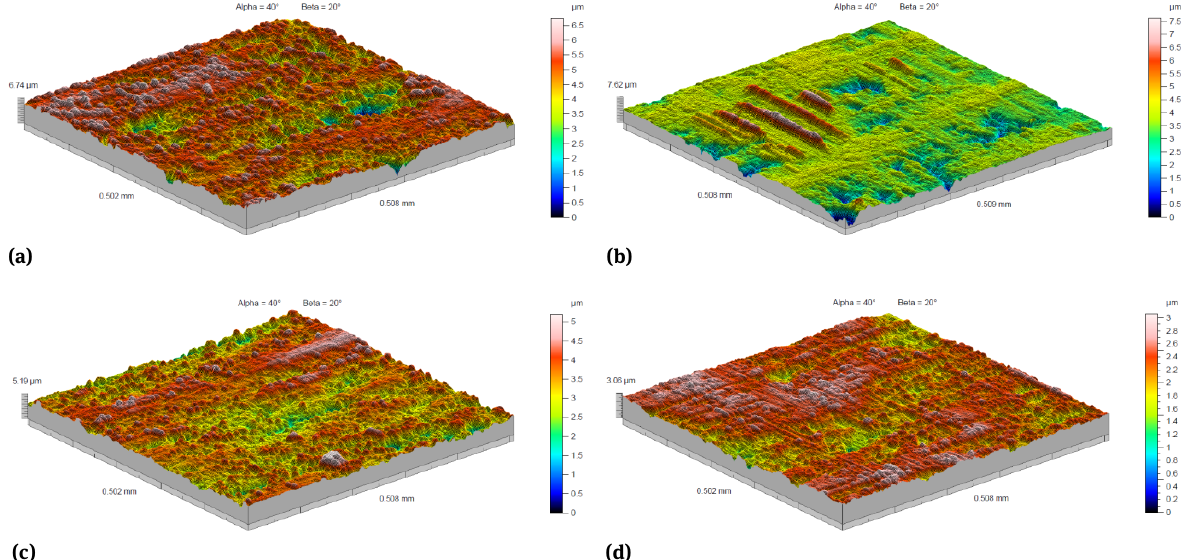
Figure 10: Isometric image a) of sample 4 before the tribological test b) of sample 4 after the tribological test c) of sample 5 before the tribological test d) of sample 5 after the tribological